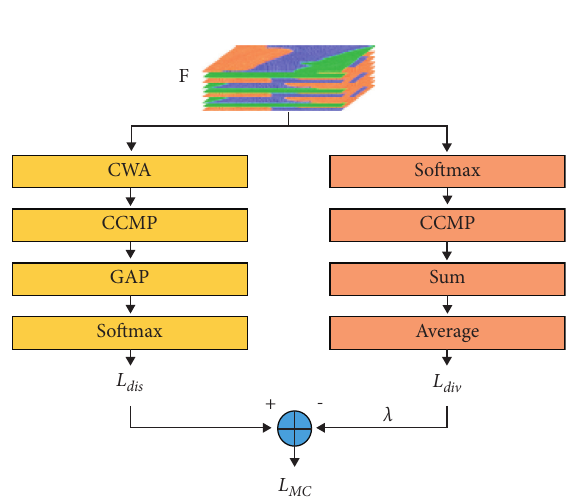
Figure 14: Overview of the